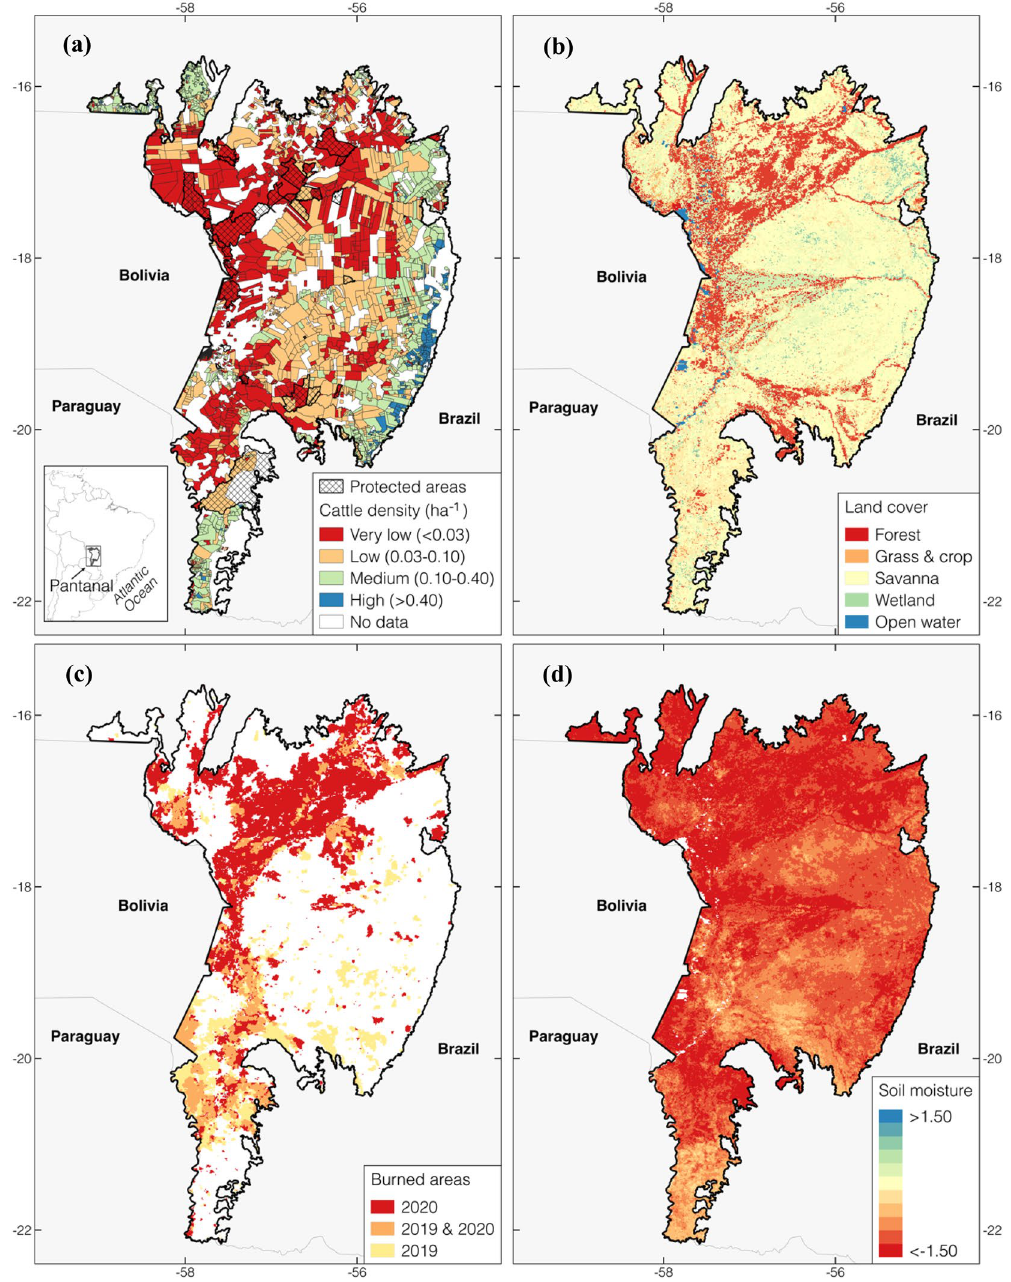
Figure 1. Map of the study domain over the Pantanal: ( a ) shows four categories of pasture based on cattle head density per cattle ranch (estimated from the Mapbiomas project 37 ), with the conservation areas (shown in the hatched patterns) with the indigenous and environmental reserves (http:// www. funai. gov. br/ index. php/ shape; https:// antigo. mma. gov. br/ areas- prote gidas/ cadas tro- nacio nal- de- ucs/ dados- georr efere nciad os. html), ( b ) shows the four dominant land cover types from the MODIS land cover data 67 , ( c ) shows the locations of the burned areas in 2019 and 2020, based on the MCD64A1 burned area product 43 , and ( d ) shows a map of the standardized 6-month root zone soil moisture anomaly averaged across the Aug-Nov of 2020. The spatial maps are created using QGIS (https:// qgis. org/ en/